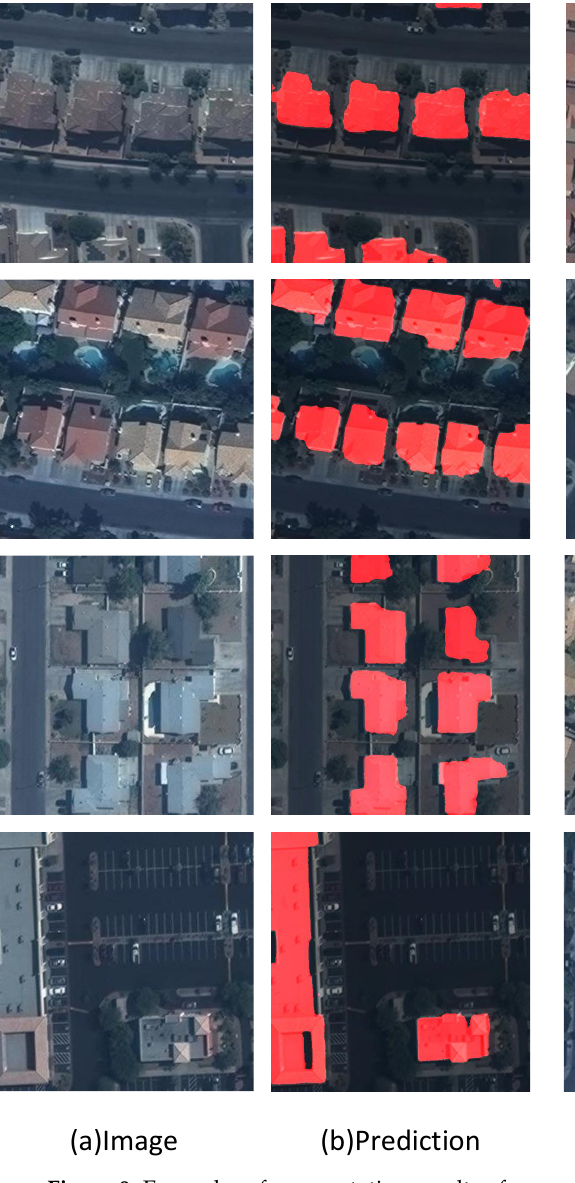
Figure 9. Examples of segmentation results of our method on mapping challenge dataset. ( a ) Image. ( b )